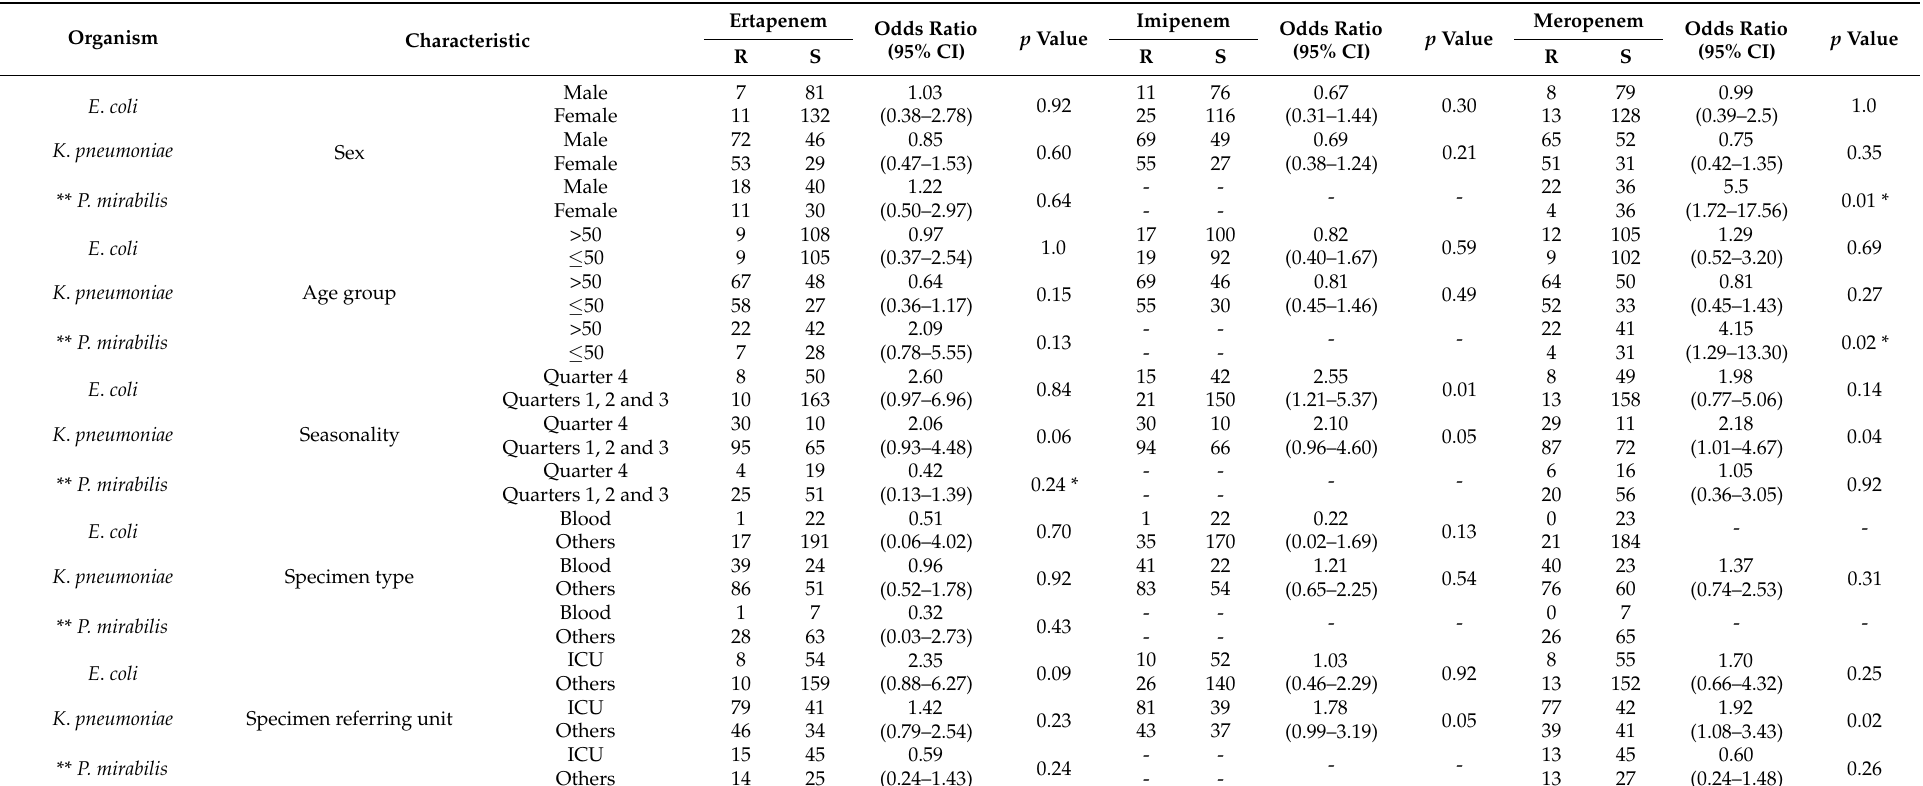
Table 4. Carbapenem resistance distribution characteristics of predominant Enterobacterales